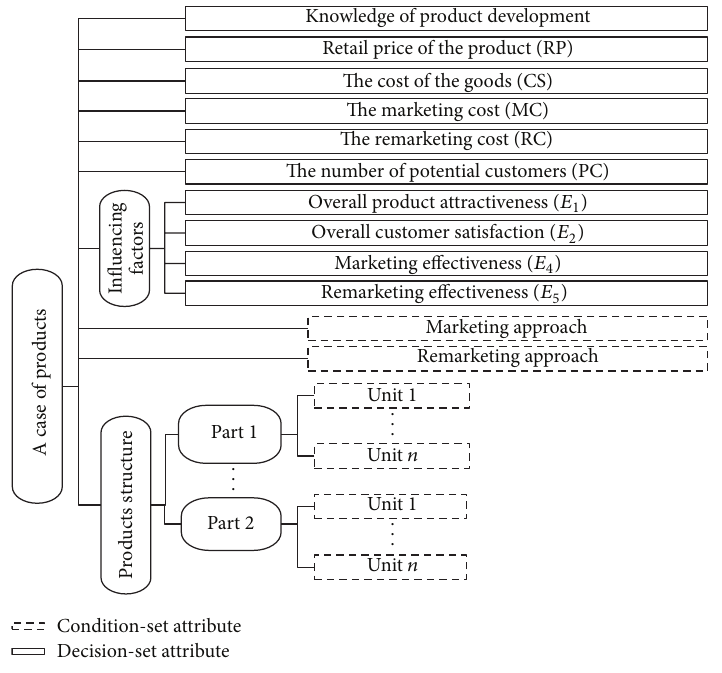
Figure 3: The frame representation results for the product